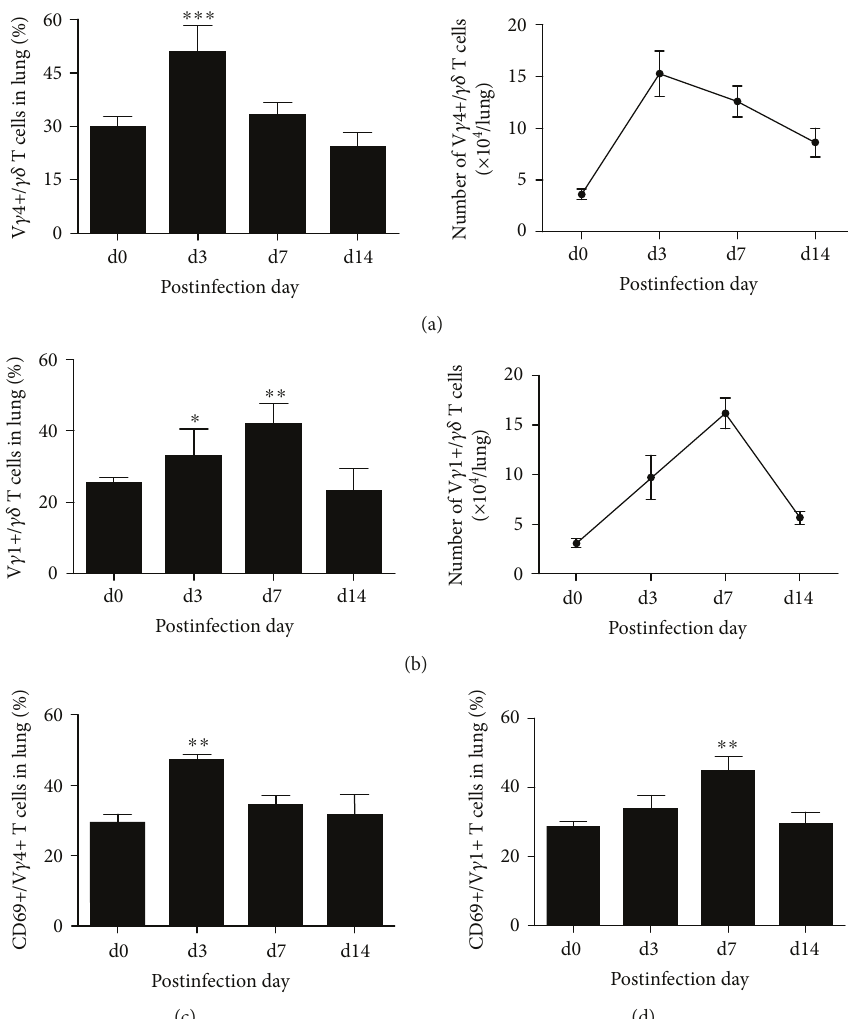
Figure 3: V γ 1+ T and V γ 4+ T cell proliferated and activated during Cm respiratory infection. Mononuclear cells in lung tissues at di ff erent time points postinfection were extracted. Staining with anti-mouse CD3, TCR γδ , TCRV γ 1, and TCRV γ 4 antibody to analyze the percentage and absolute number of TCRV γ 1+ TCR γδ + T cells (a) and TCRV γ 4 + TCR γδ + T cells (b) by fl ow cytometry. The activation extent of V γ 1+ T (c) and V γ 4+ T (d) cell was measured by the expression of CD69, staining with anti-mouse CD69 antibody. The results are presented as mean ± SD. ∗ p < 0 05 , ∗∗ p < 0 01 , and ∗∗∗ p < 0 001